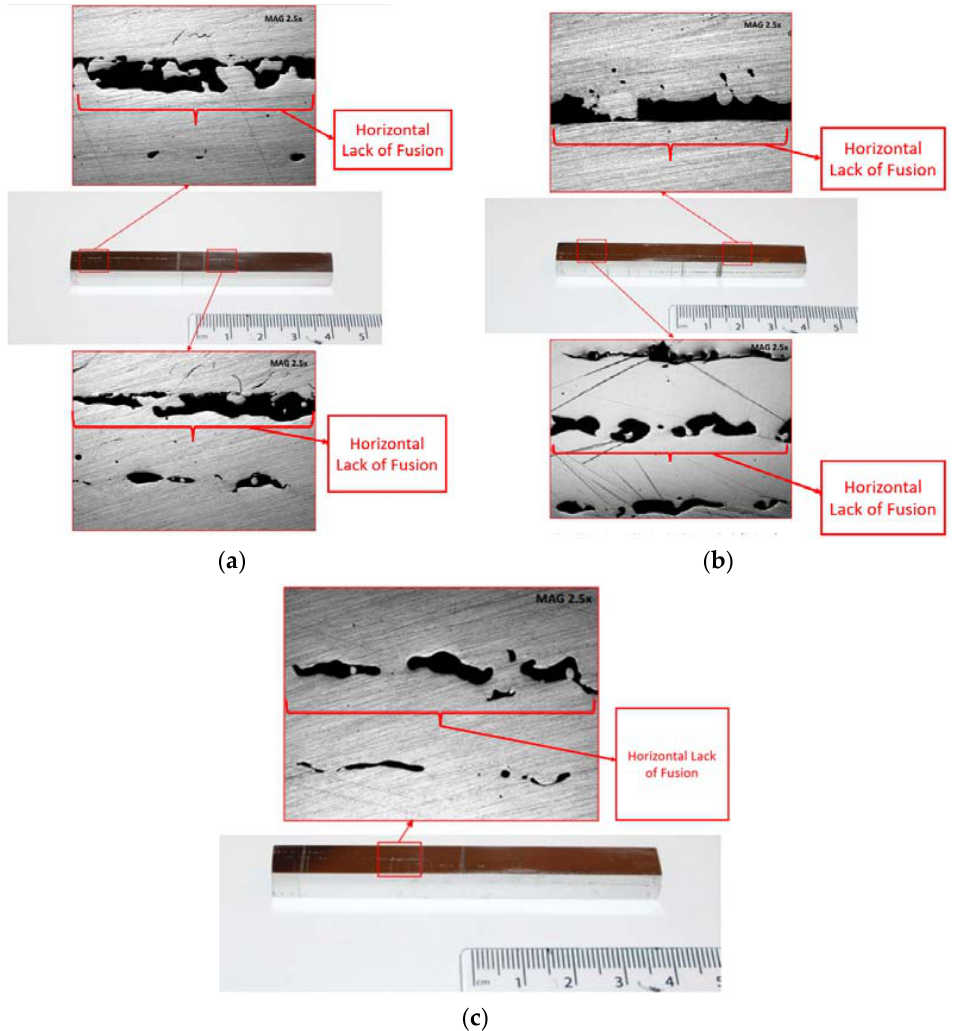
Figure 7. Primary microscopic observations with details of horizontal lack of fusion defects in different specimens: ( a ) specimen No. 1, ( b ) specimen No. 2, and ( c ) specimen No. 3.